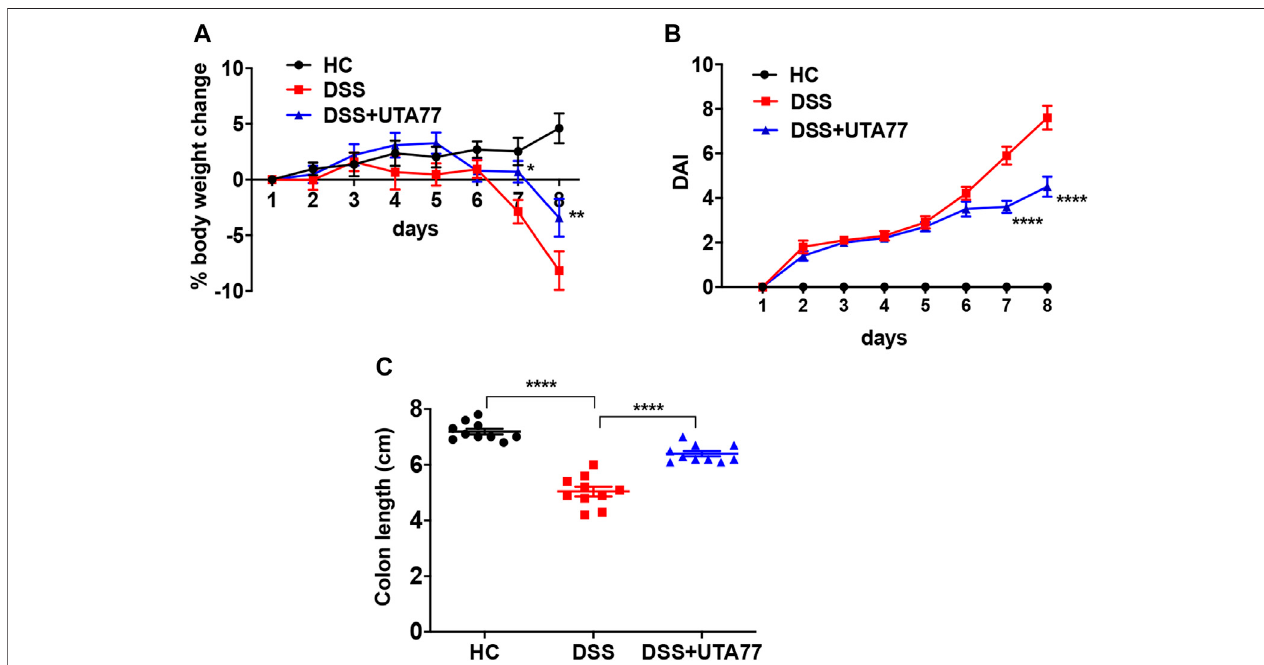
FIGURE 2 | Effect of UTA77 on the pathology of DSS-induced experimental colitis. (A) % body weight change; (B) disease Activity Index (DAI). Statistical signi fi canceamonggroupsevaluatedbytwo-wayANOVAfollowedbyTukey ’ sposttest. *p < 0.05, **p < 0.01,and ****p < 0.0001vs.DSS. (C) Colonlengthevaluatedby one-way ANOVA followed by Tukey ’ s posttest. Data expressed as mean ± SEM ( n (cid:1)